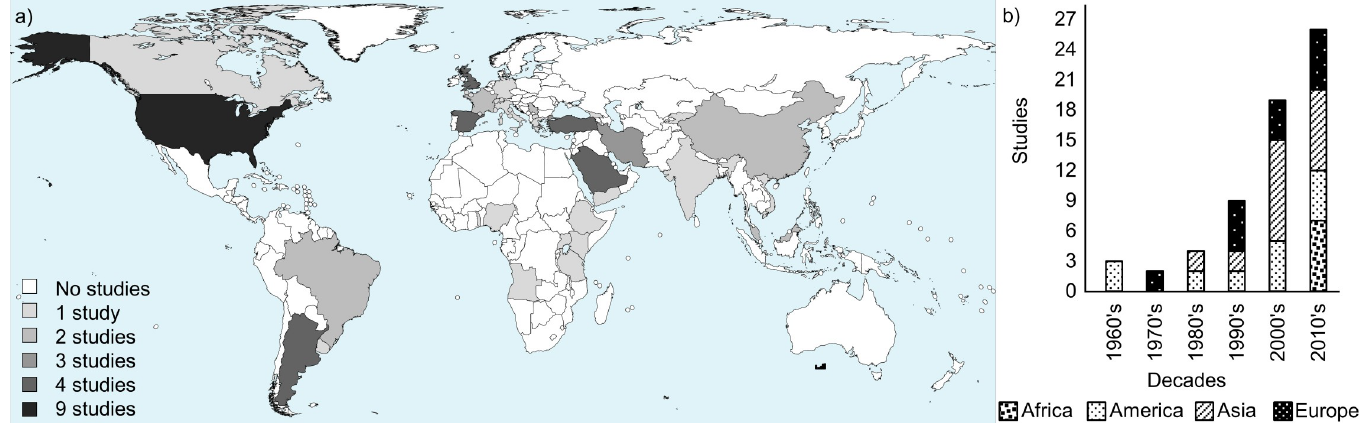
Fig 2. Geographical and temporal distribution of the selected articles included in the present study. (a) Distribution and frequency of occupational brucellosis studies published by country (performed with aid of online dataset: https://commons.wikimedia.org/wiki/Atlas_of_the_world). (b) Distribution and frequency of occupational brucellosis studies published by continent and decade, from 1962 to